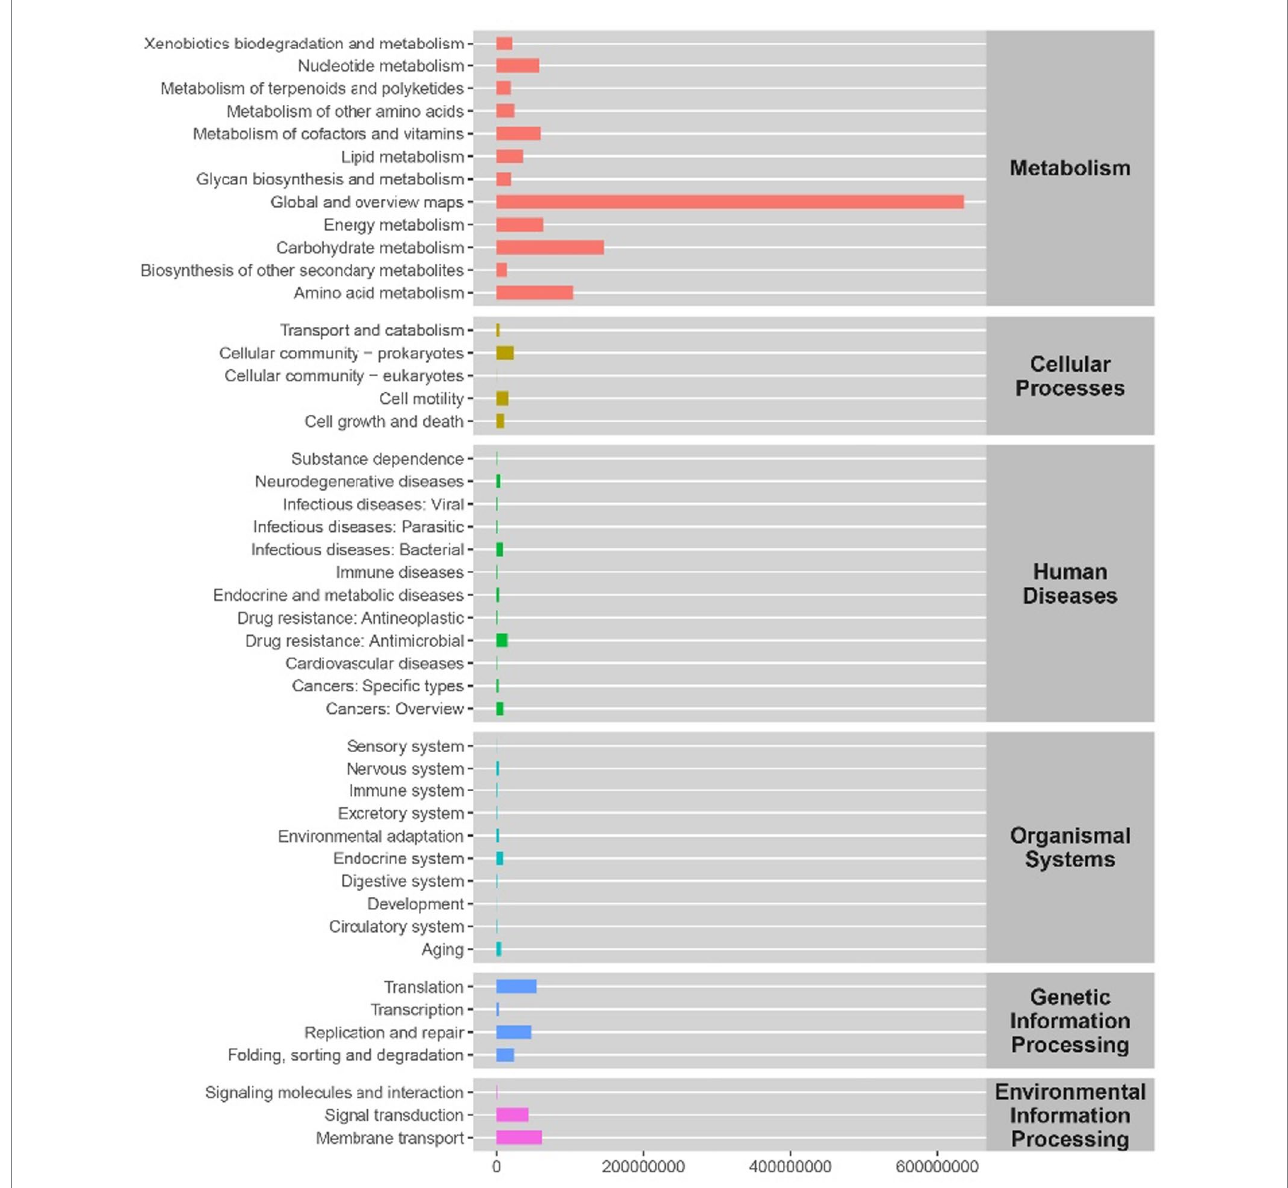
FIGURE 10 The predicted functional abundance of intestinal mucosal microbiota KEGG in mice with spleen deficiency constipation during SMD